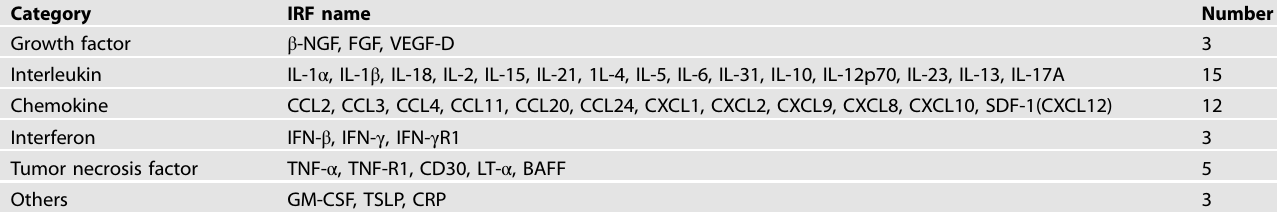
Table 3. Characteristics of 41 immune-related